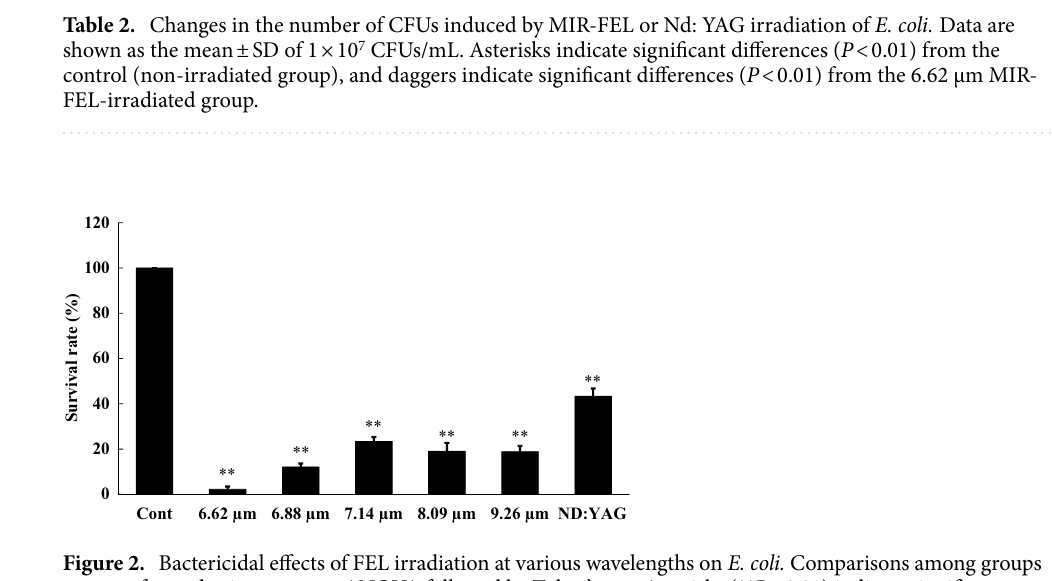
Figure 2. Bactericidal effects of FEL irradiation at various wavelengths on E. coli. Comparisons among groups were performed using one-way ANOVA followed by Tukey’s test. Asterisks (** P < 0.01) indicate significant differences from the non-irradiated group or the 15-min MIR-FEL irradiation